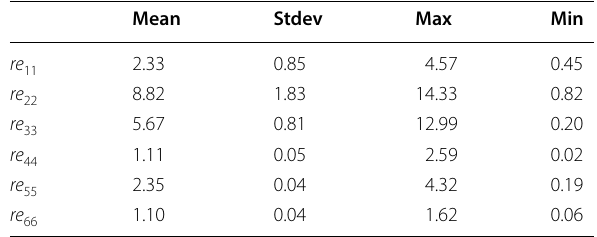
Table 4 Statistics on relative errors re elements of stiffness